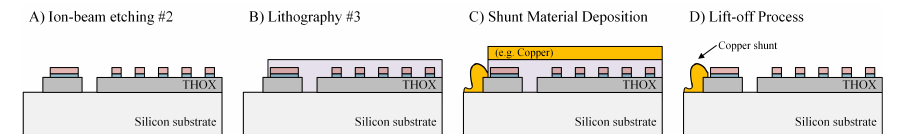
Figure 4. Steps required for fabrication of thermal demonstrators with heat shunts. ( A ) Starting point is step “G” in Figure 3. ( B ) Third lithography step using lift-off photo-resist to define the position of the shunts.